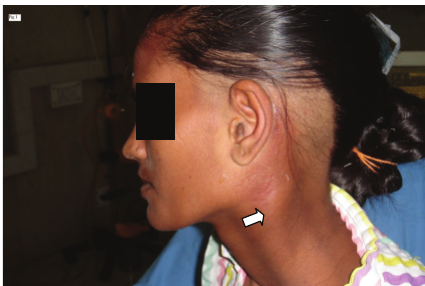
Figure 1: Photograph of the patient showing upper neck swelling.